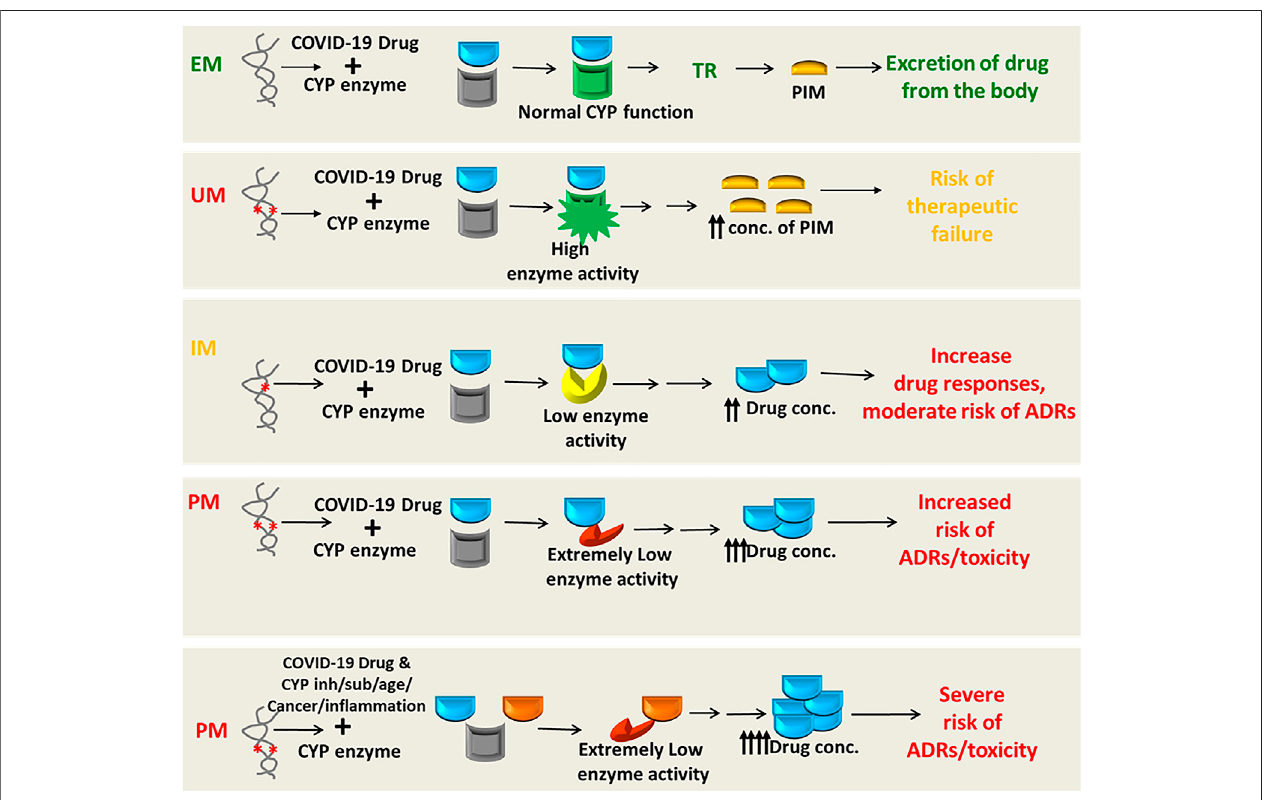
FIGURE 7 | Predictive model of multifactorial DGIs for a COVID-19 drug showing possible effects of CYP gene variants representing likely phenotypes associated withtheriskoftherapeuticfailureorADRs/toxicity.Here,DGIs,drug – geneinteractions;COVID-19,coronavirusdisease-2019;EM,extensivemetabolizer;UM,ultrarapid metabolizer; IM, intermediate metabolizer; PM, poor metabolizer; CYP, cytochrome P450 enzyme; *indicates CYP gene variant; Inh, inhibitor; Subs, substrate; TR, therapeutic response; PIM, pharmacologically inactive metabolite; ADRs, adverse drug reactions; conc., concentration.